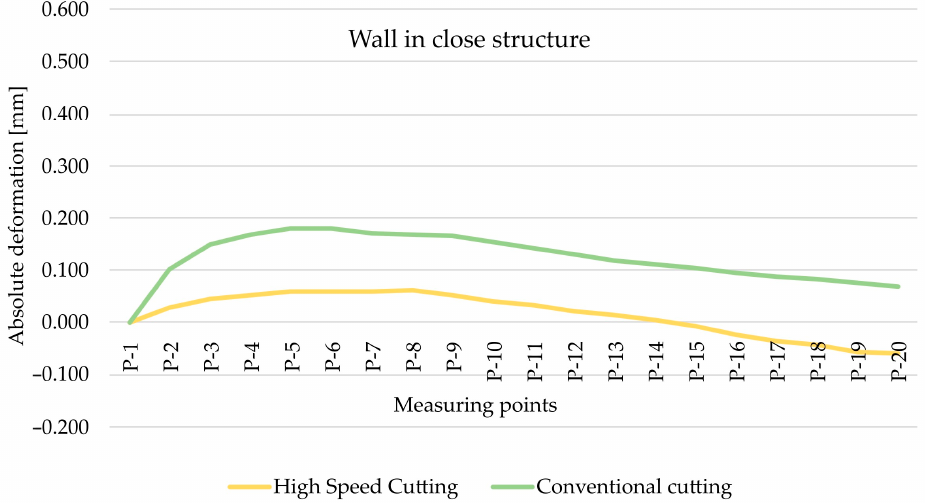
Figure 10. The comparison of absolute deformation for individual measurement points depending on the cutting type for the element with walls arranged in a closed structure made of the EN AW-7075 T651 aluminium alloy.